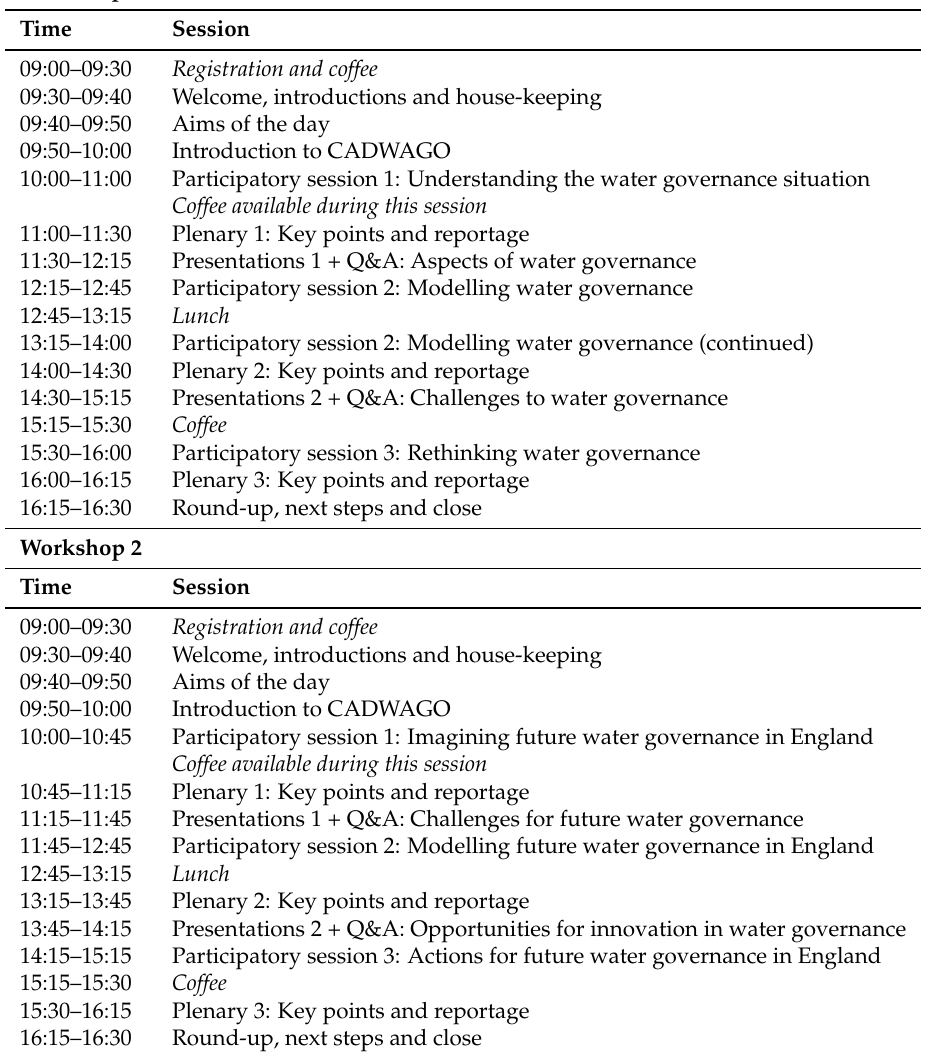
Table 1. Workshop